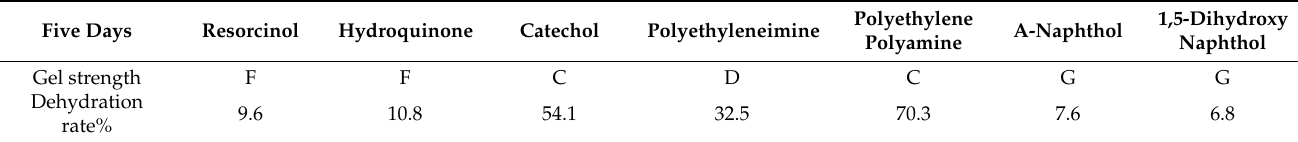
Table 3. Effects of cross-linkers on the Gel Dehydration